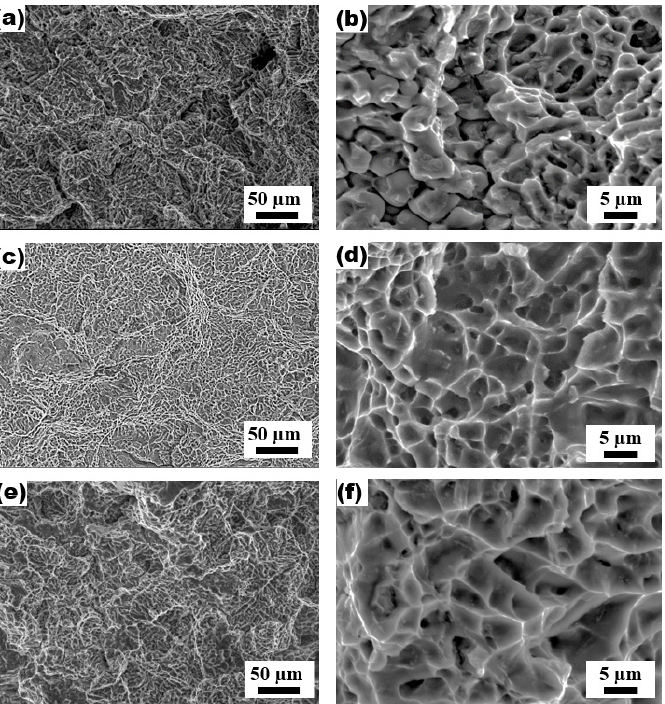
Figure 15. Fracture surfaces of welded AA7075-T6 samples under condition ( a , b ) standard (no heat treatment); ( c , d ) water-quenched; ( e , f ) air-quenched.